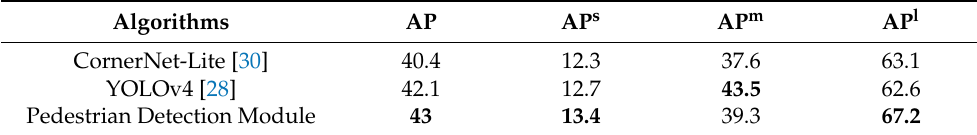
Pedestrian Detection Module